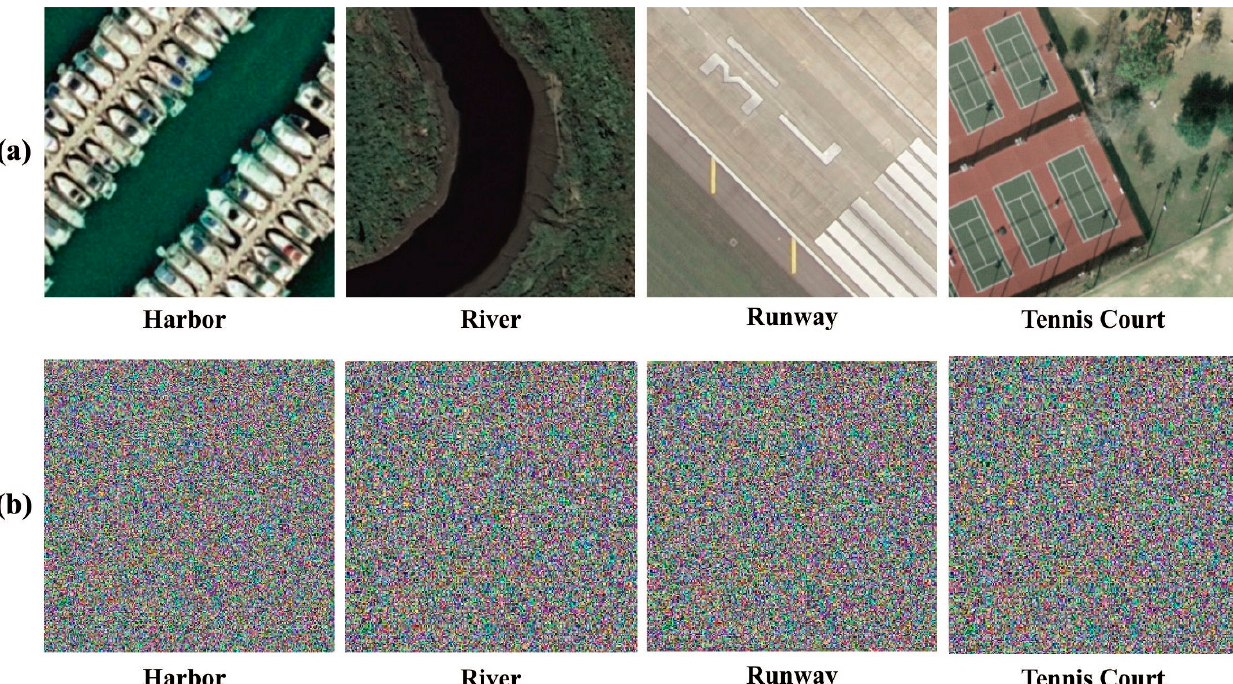
Figure 3. ( a ) Original images; ( b ) encrypted images.